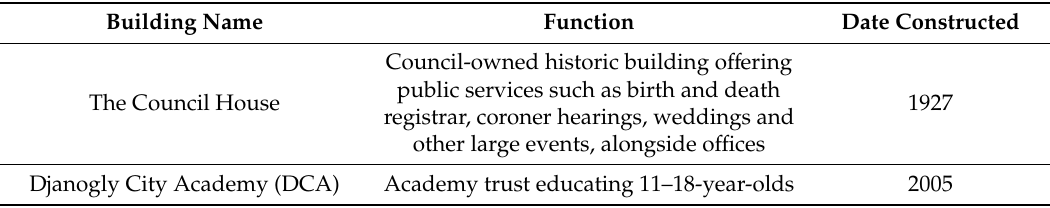
Table 4. Pilot buildings in